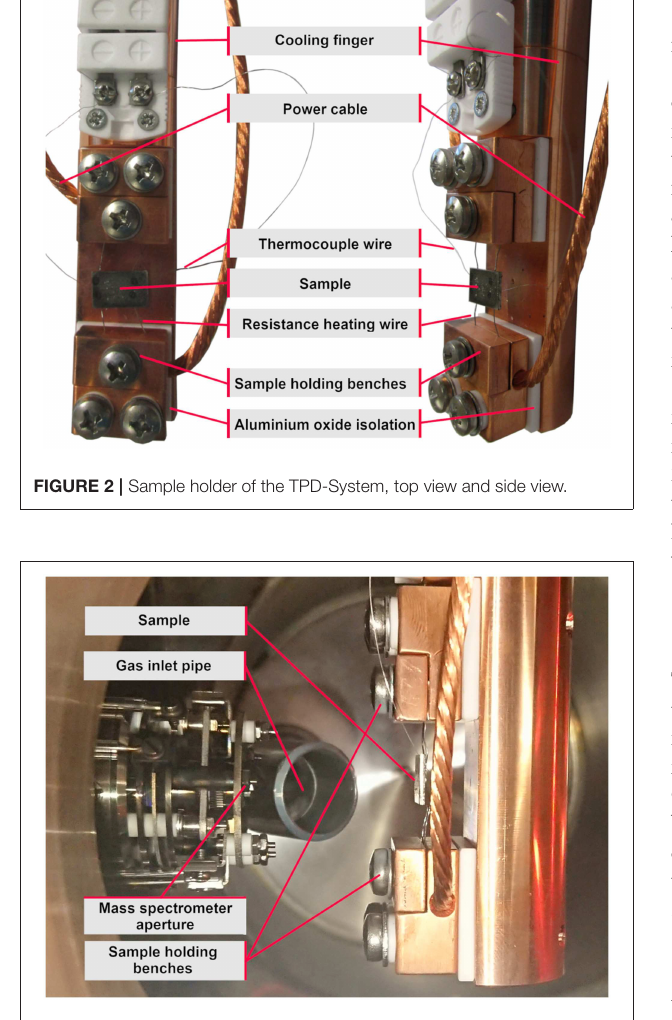
FIGURE 3 | Vacuum chamber inside